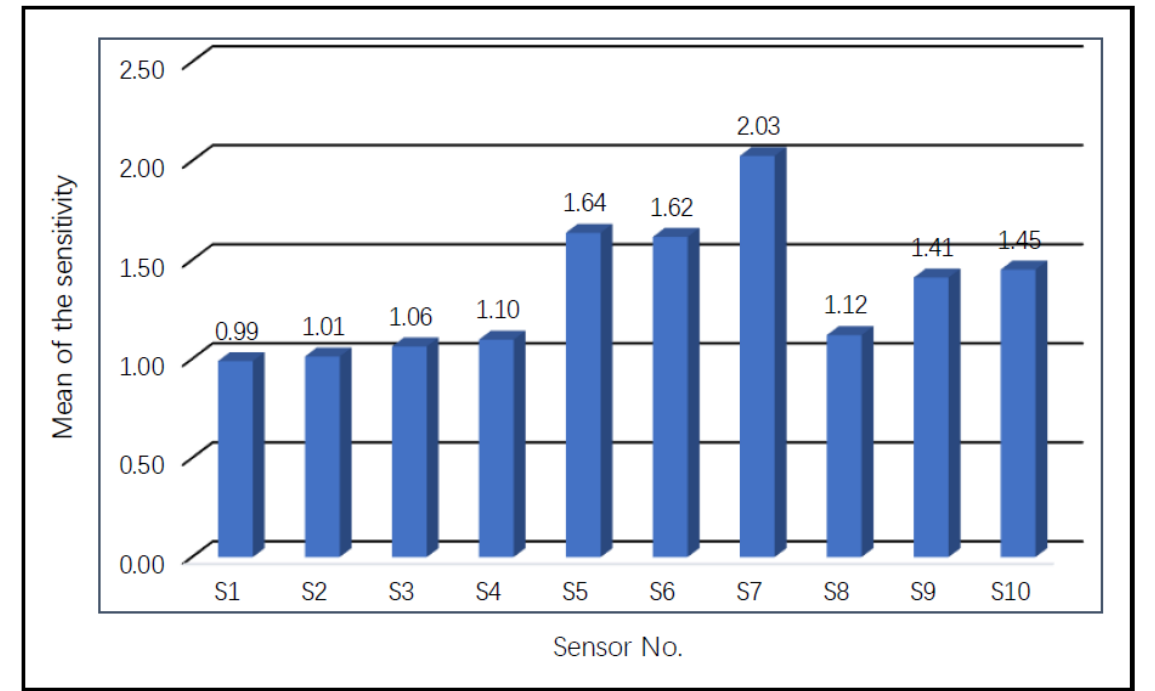
Figure 4. Average sensitivities of different sensors to the experimental gas mixtures.